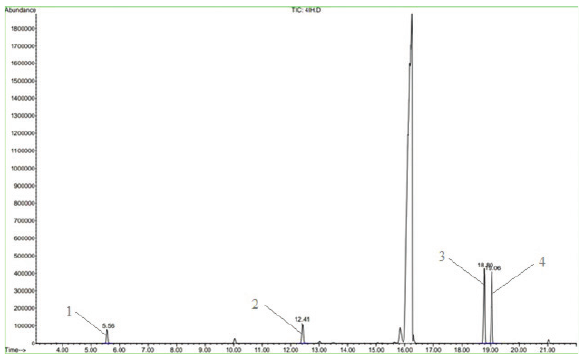
Figure 6. Chromatogram of free carbohydrates in the herbal mixture No. 7 (1 – arabinose, internal standard; 2 – glucose; 3–4 – fructose; 5 –